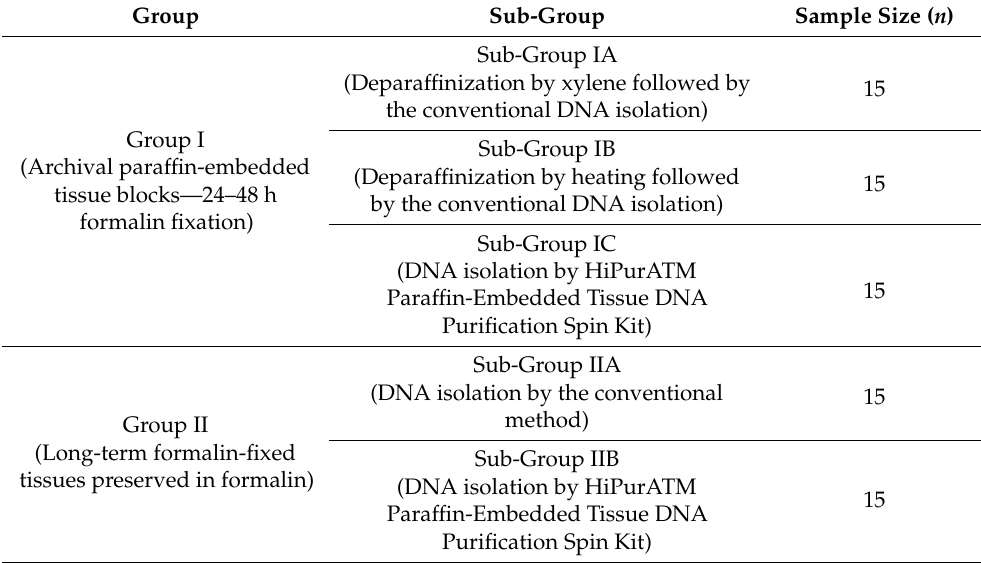
Table 1. Details of sample groups and